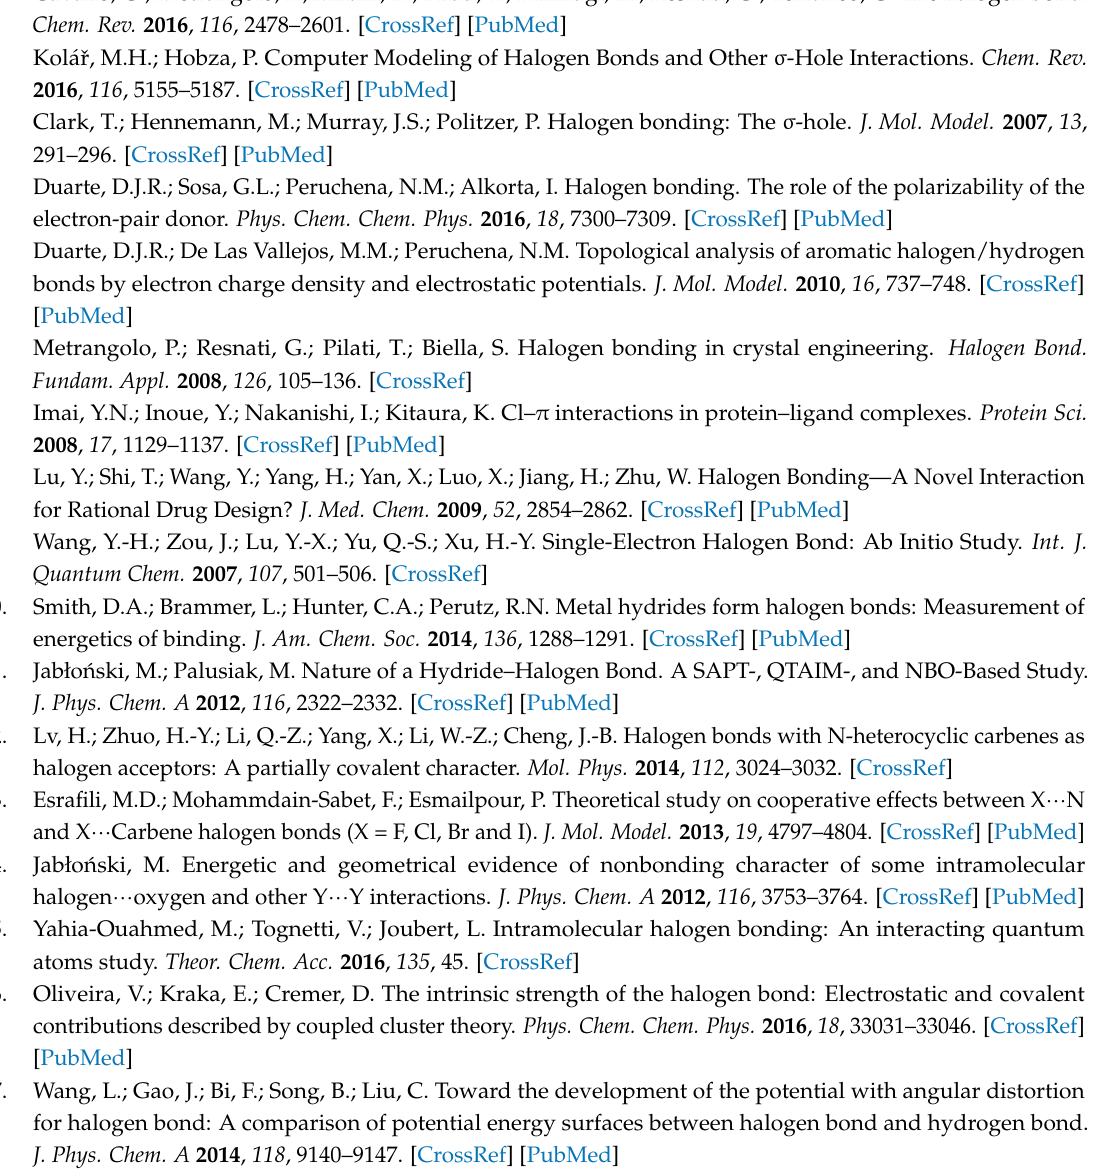
Supplementary Materials: Supplementary materials are available online. Table S1: Local topological properties of the electron charge density at the X ··· N and X ··· X interactions BCP, Figure S1: Correlation of E stab (X ··· N)| with | V ( r b )| and G ( r b ), Figure S2: Correlation of ρ ( r b ) (X ··· N) with | V ( r b )| and G ( r b ), and Figure S3: Correlation between V S ,max and E stab (X ···